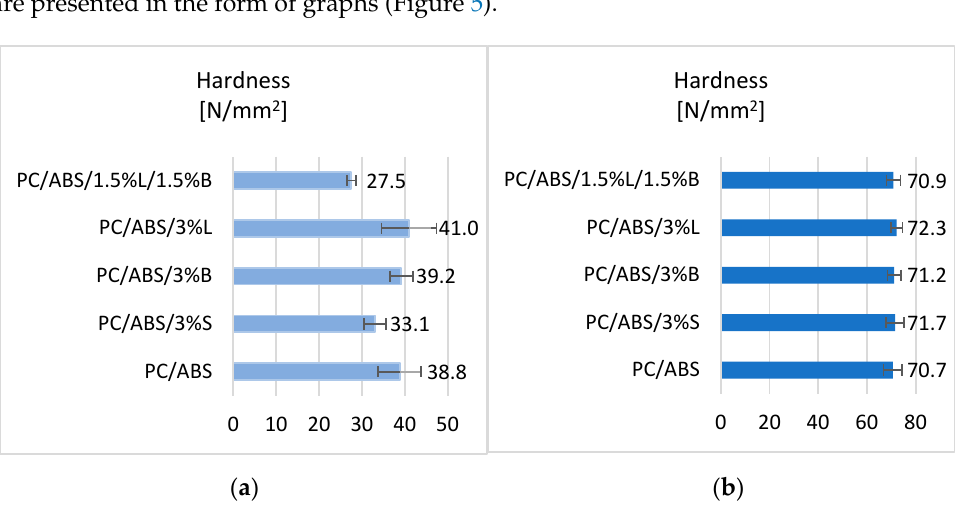
Figure 5. Hardness test results of ( a ) samples obtained by 3D printing and ( b ) samples obtained by injection molding.